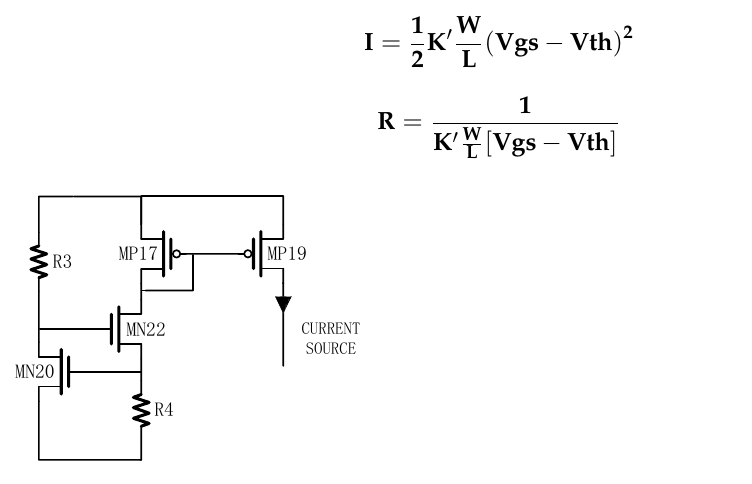
Figure 9. Bias current source.